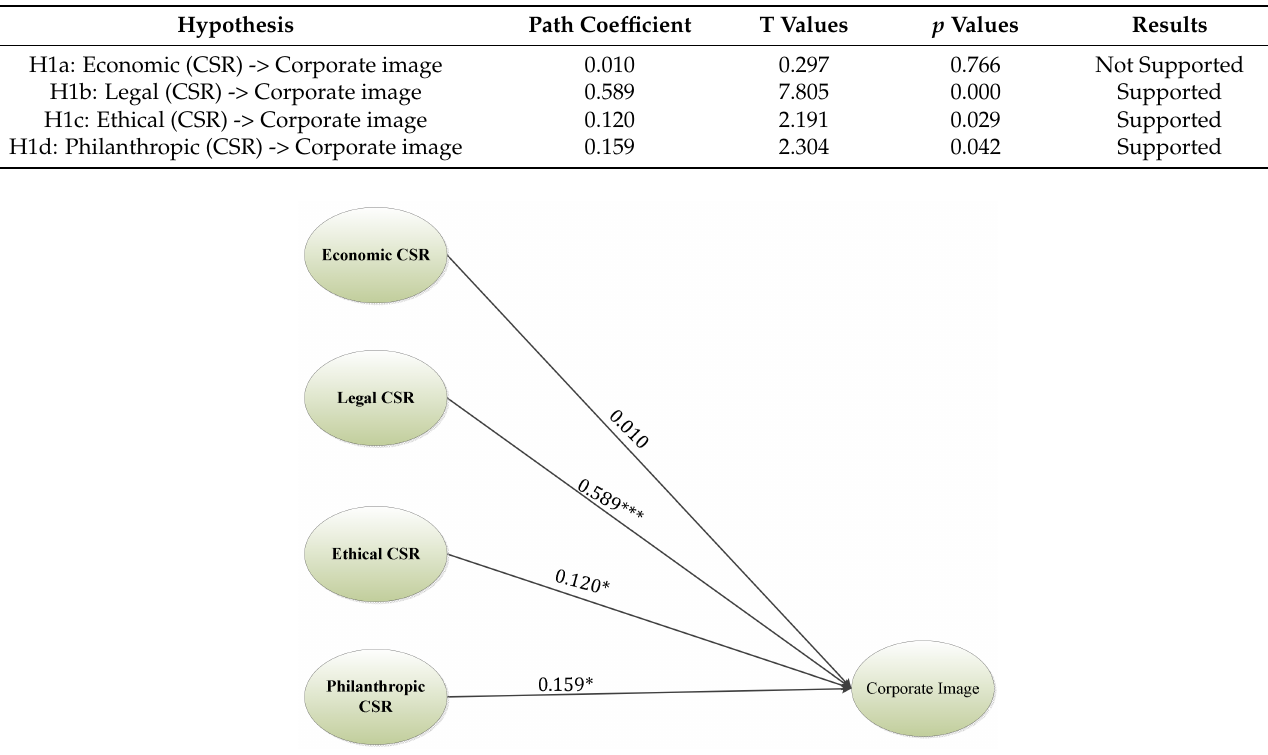
Figure 2. Results of the inner model A. Note: *** p -value < 0.001, * p -value < 0.05.